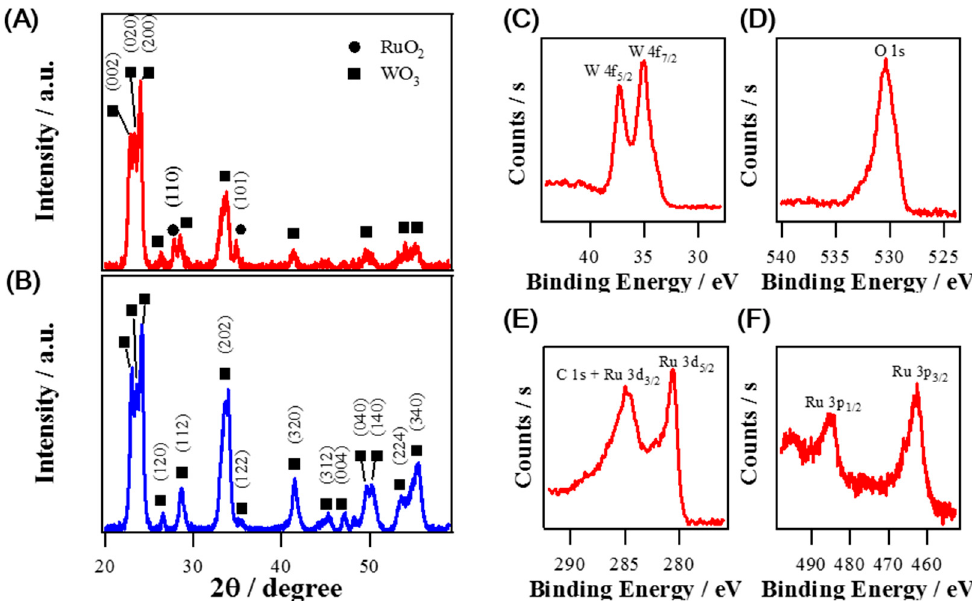
Figure 2. ( A ) XRD spectrum for RuO 2 NRs-WO 3 NFs ( B ) XRD spectrum for pure WO 3 NFs. ( C )–( F ) high resolution XPS spectra for RuO 2 NRs-WO 3 NFs, ( C ) W 4f, ( D ) O 1s, ( E ) Ru 3d, and ( F ) Ru 3p regions, respectively.